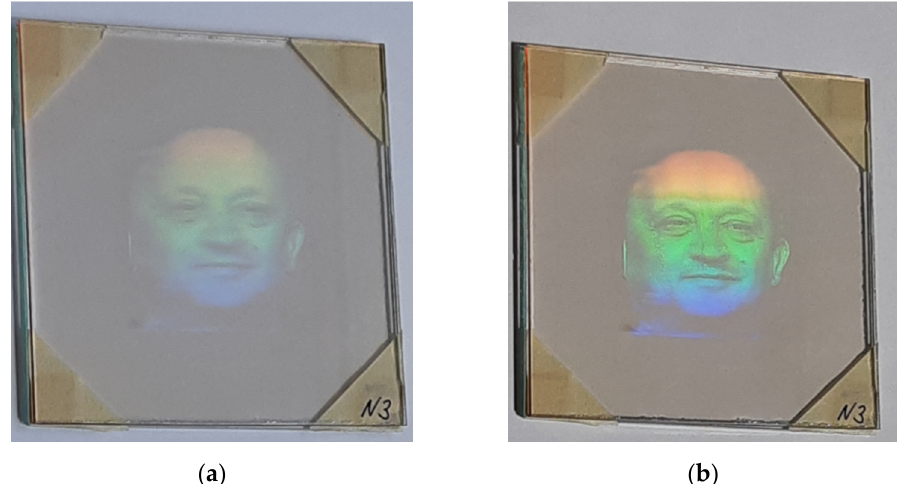
Figure 9. A rainbow hologram of the object shown in Figure 1, in the sunlight: ( a ) light scattered by a cloud; ( b ) direct sunlight.